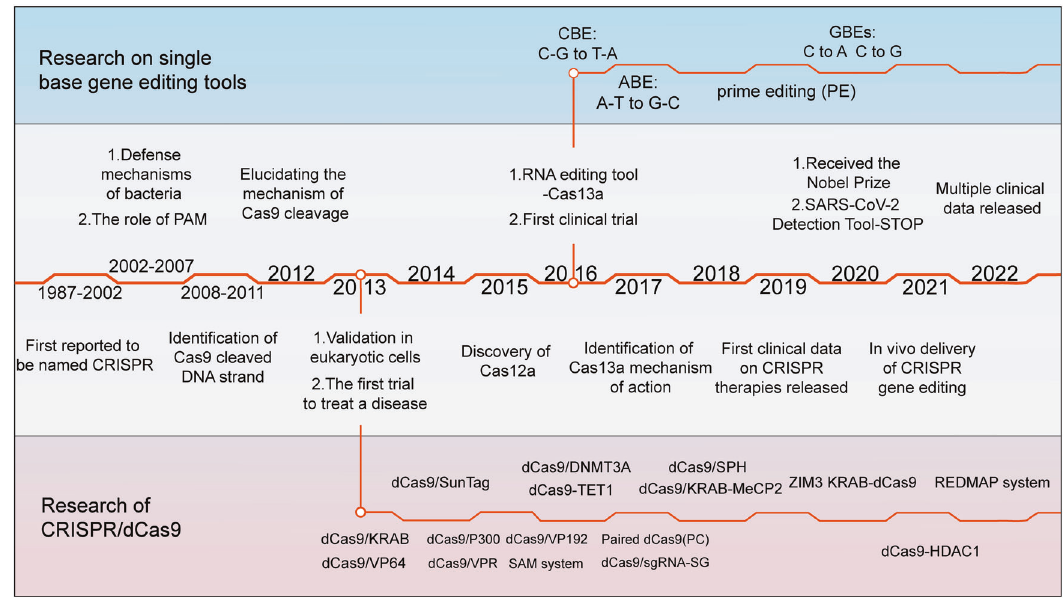
Fig. 1 Timeline of major events in the development of CRISPR/Cas technology and representative Cas9 variants. In 1987, the CRISPR sequence was fi rst reported. The mechanism by which Cas9 cuts DNA double strands was reported in 2012, and Cas9 was subsequently used for gene editing in mammalian cells. Since then, CRISPR technology has developed rapidly, and multiple Cas9 variants with speci fi c functions have been identi fi ed. The representative variants are single-base substitution tools (e.g., CBE and PE) and transcriptional regulatory tools (e.g., dCas9-effector). Since 2016, CRISPR-based gene-editing technologies have been successively used in clinical treatment with great success. CRISPR clustered regularly interspaced short palindromic repeats, Cas CRISPR-associated, dCas9 dead Cas9, PAM protospacer-adjacent